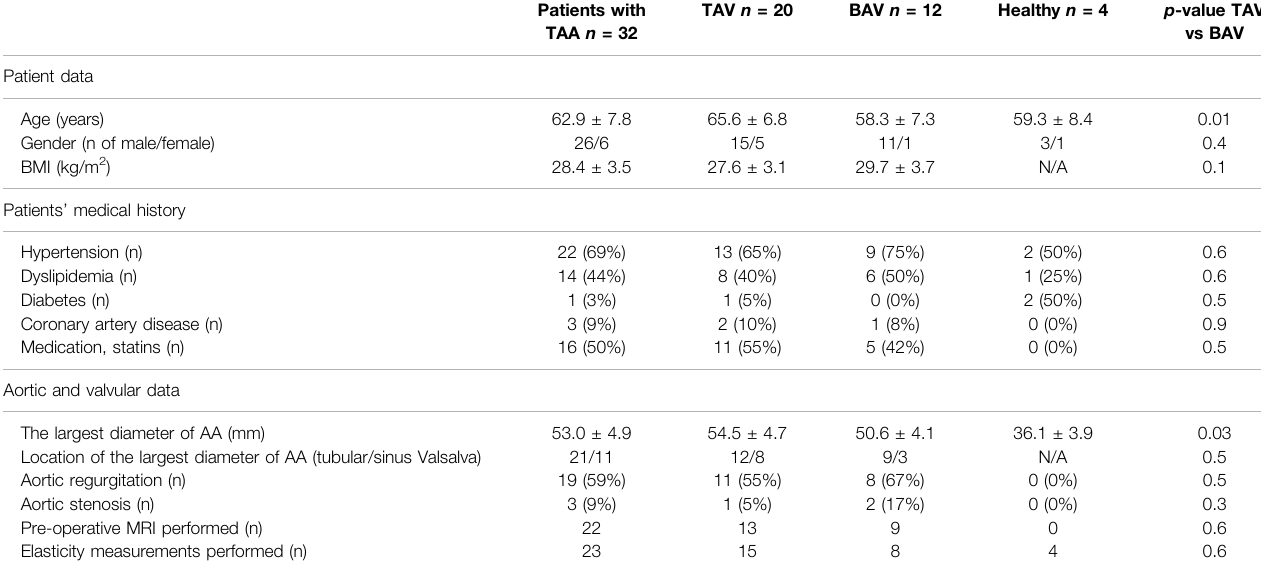
TABLE 1 | Patient